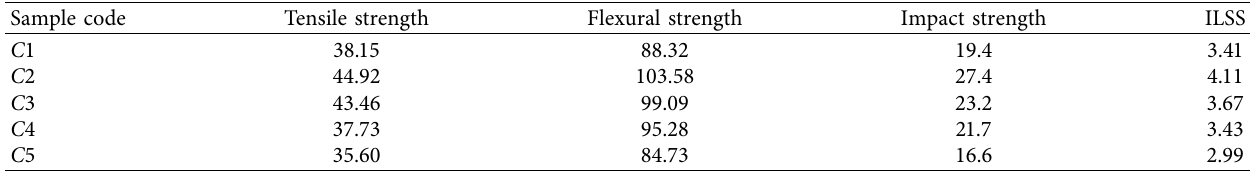
Table 2: Derived results from the experiment.